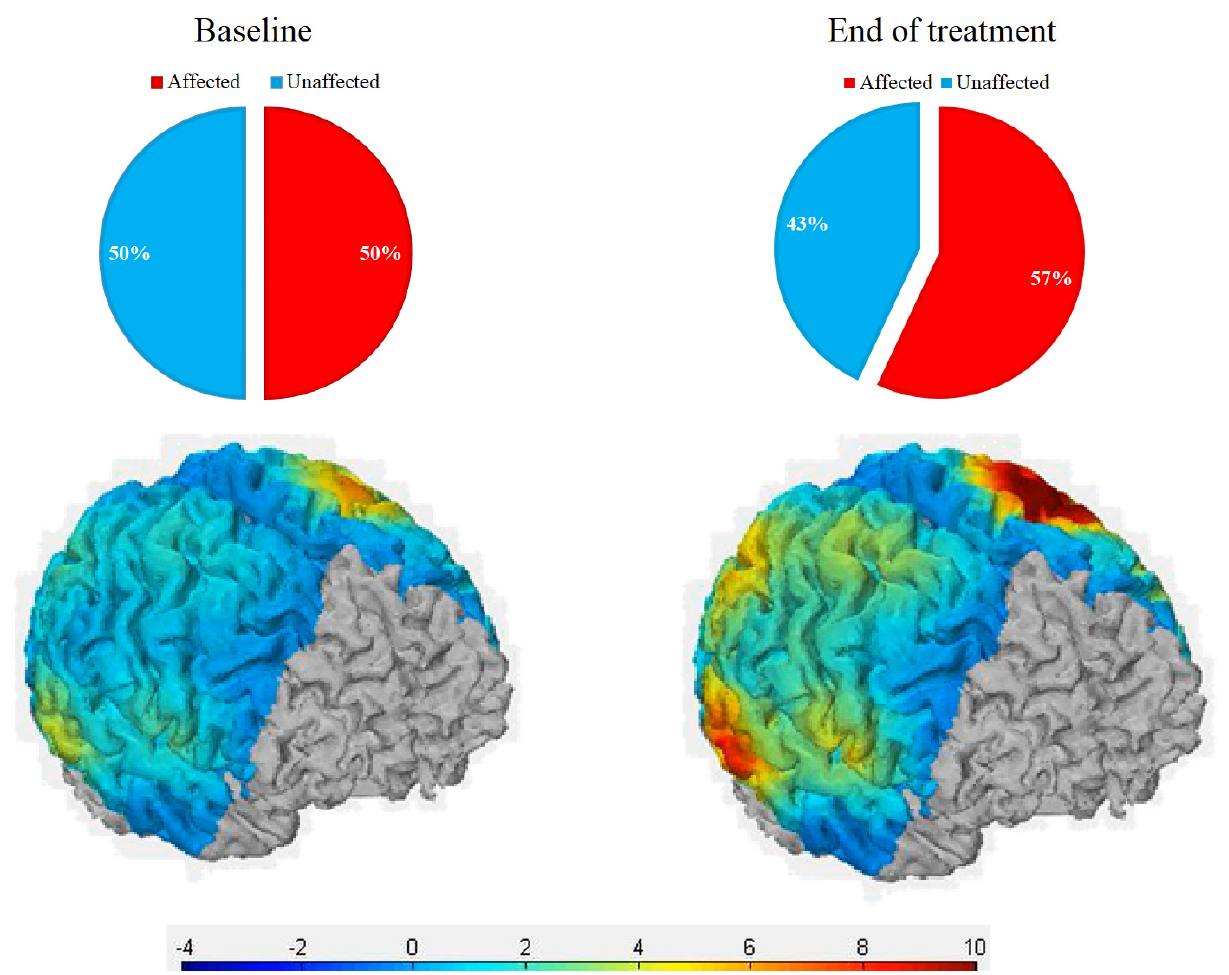
Figure 6. Representation of mean cortical oxygenation during the motor task for the affected ( front ) and unaffected ( back ) hemispheres. Legend: scale of cortical oxygenation to be multiplied by 10 E5 units.